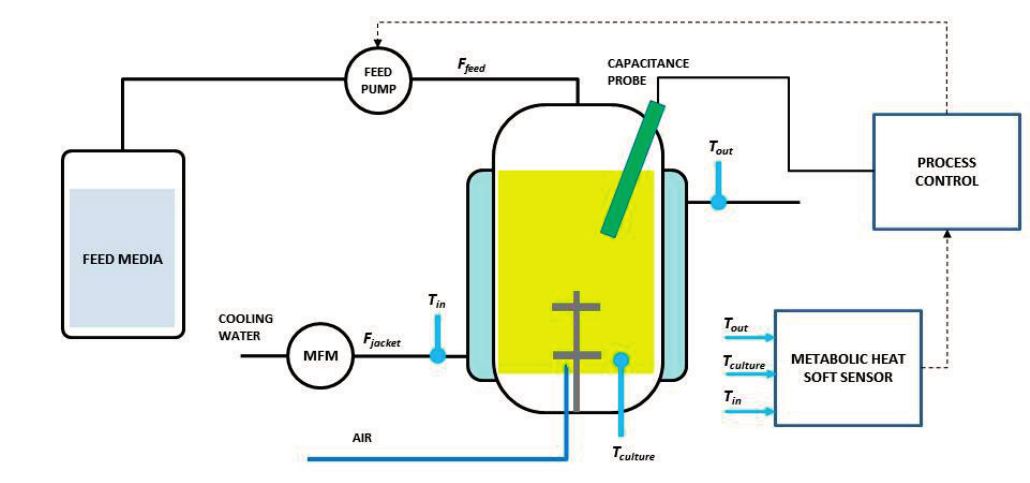
Figure 2. Experimental set-up of the soft